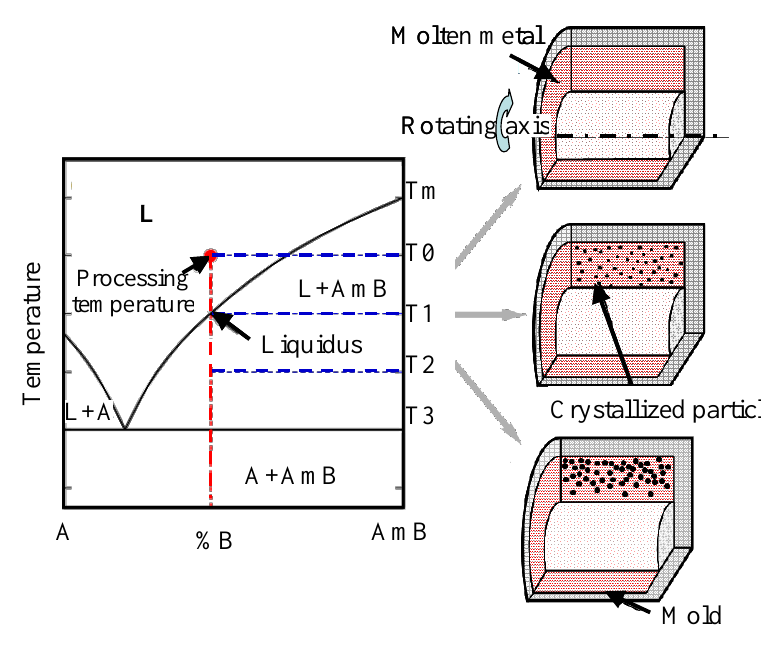
Figure 2. The schematic illustration of CISM